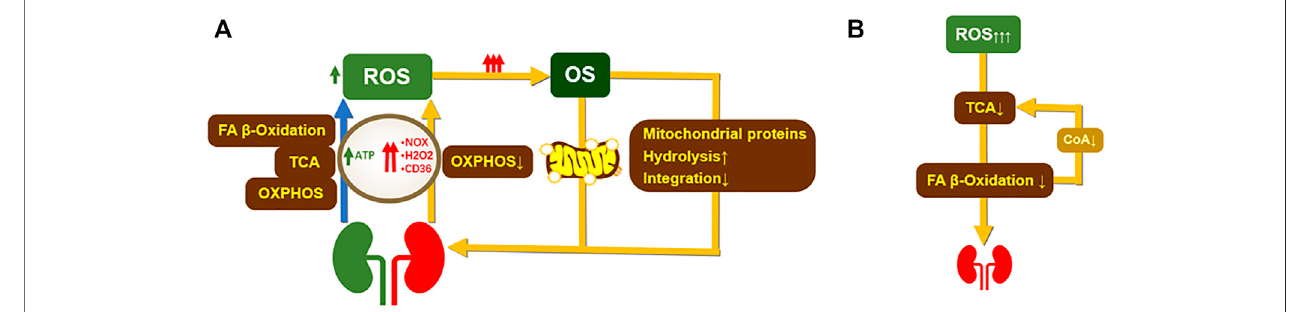
FIGURE 2 | The occurrence of renal oxidative stress affects mitochondrial structure and function. (A) . In normal humans, oxidative phosphorylation, tricarboxylic acid cycle, and FA- β -oxidation provide energy to the kidney and induce the production of low doses of ROS. OXPHOS mainly provide ATP to the proximal tubule to maintainthenormalphysiologicalfunctionofthekidney.AdecreaseinOXPHOScapacityduringkidneydamageleadstoanincreaseinNOXlevels.AbnormalNOXlevels leadtoexcessiveROSproductionexacerbatingoxidativestressandin fl ammationandinducingthedevelopmentofrenal fi brosis.Meanwhile,renaldiseaseimpairs mitochondrial function during OXPHOS due to reduced renal degradation of H 2 O 2 a FA- β nd disrupts FA- β oxidation. overexpression of CD36 leads to reduced lipid metabolism resulting in involvement and causes impaired FA- β oxidation, leading to excessive ROS production (Ge et al., 2020; Martínez-Klimova et al., 2020). Excess ROS leads to growth mitochondrial damage, 1) decreased mitochondrial protein synthesis, and increased catabolism (Liesa and Shirihai, 2013). 2) Increased mitochondrial autophagy, which occurs mainly through degradation of proteasomes by the PINK1-Parkin pathway and phagocytic receptor interactions. (B) . Excess ROS impair FA- β -oxidation by impairing TCA cycle function. reduced FA- β -oxidation leads to lipid accumulation and aggravates renal function. In turn, impaired FA β - oxidationleadstoadecrease inacetylcoenzymeA,furtherdiminishingTCA capacity (Bobulescu, 2010).ROS,reactive oxygen species; OS,oxidativestress;OXPHOS, oxidative phosphorylation; TCA, tricarboxylic acid cycle; NOX, nicotinamide adenine dinucleotide phosphate (NADPH) oxidase; H 2 O 2 , hydrogen peroxide; CD36, long- chain FA fractionation